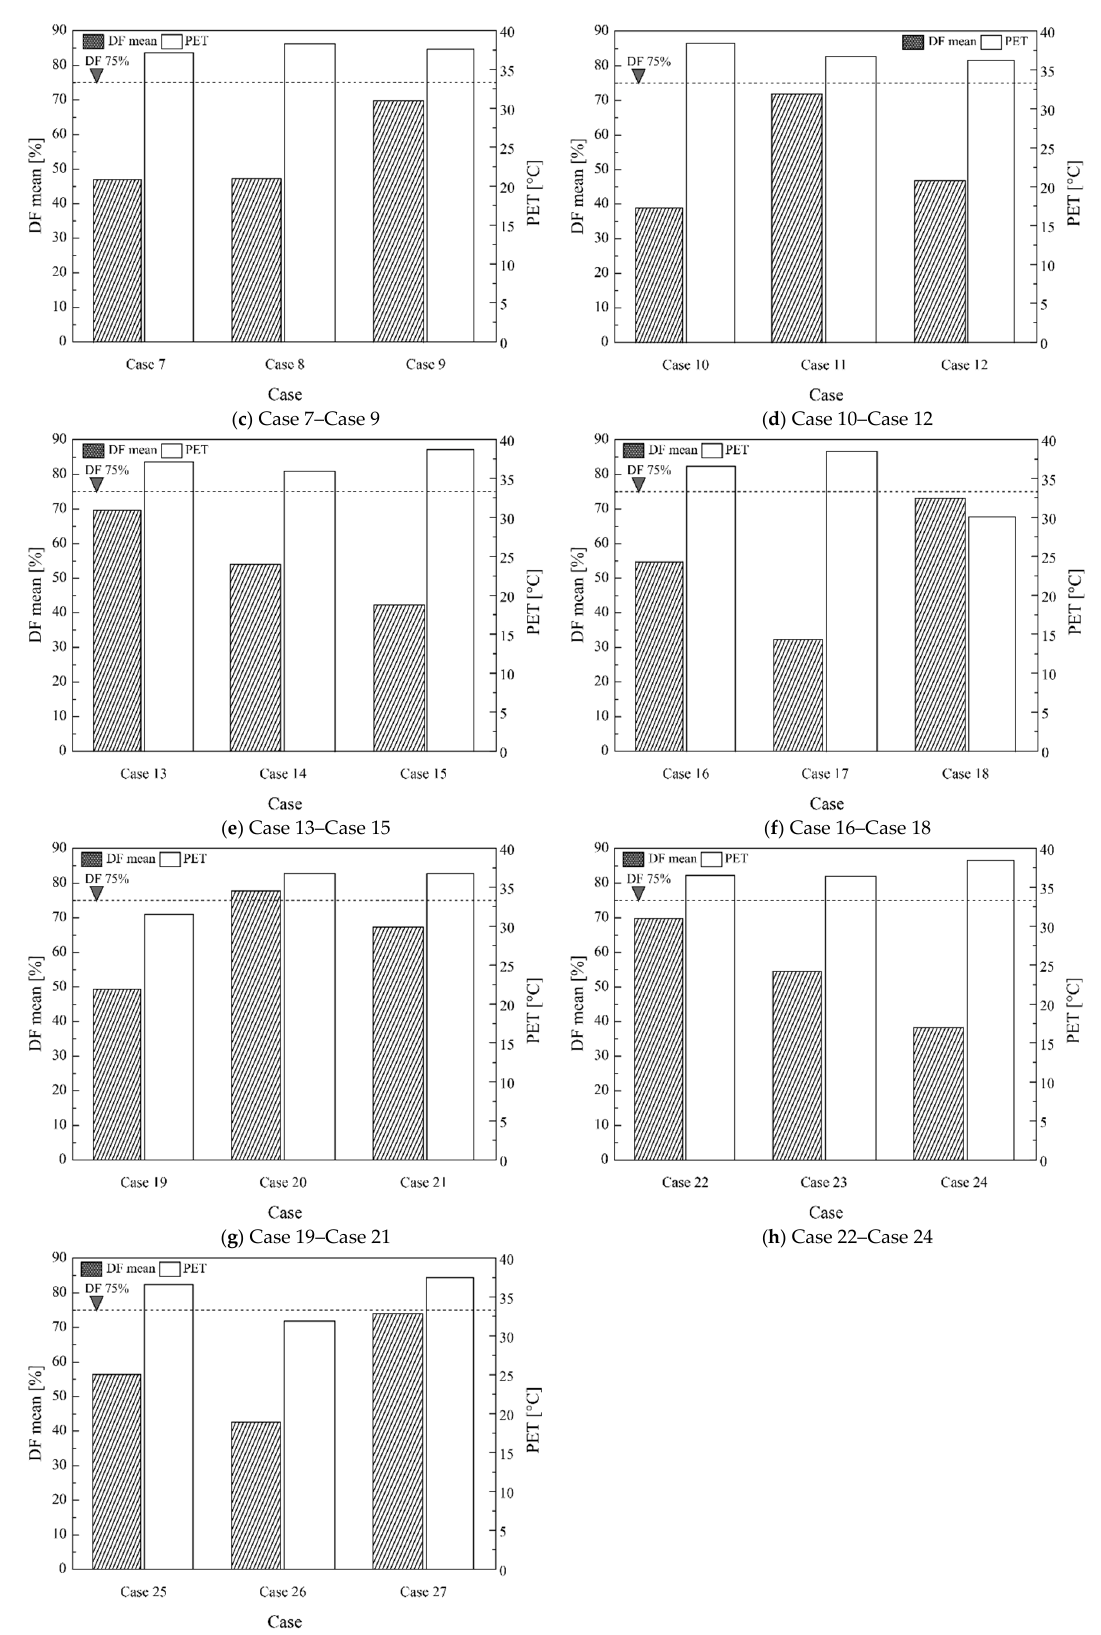
Figure 7. Simulation results outdoor thermal comfort and natural lighting.